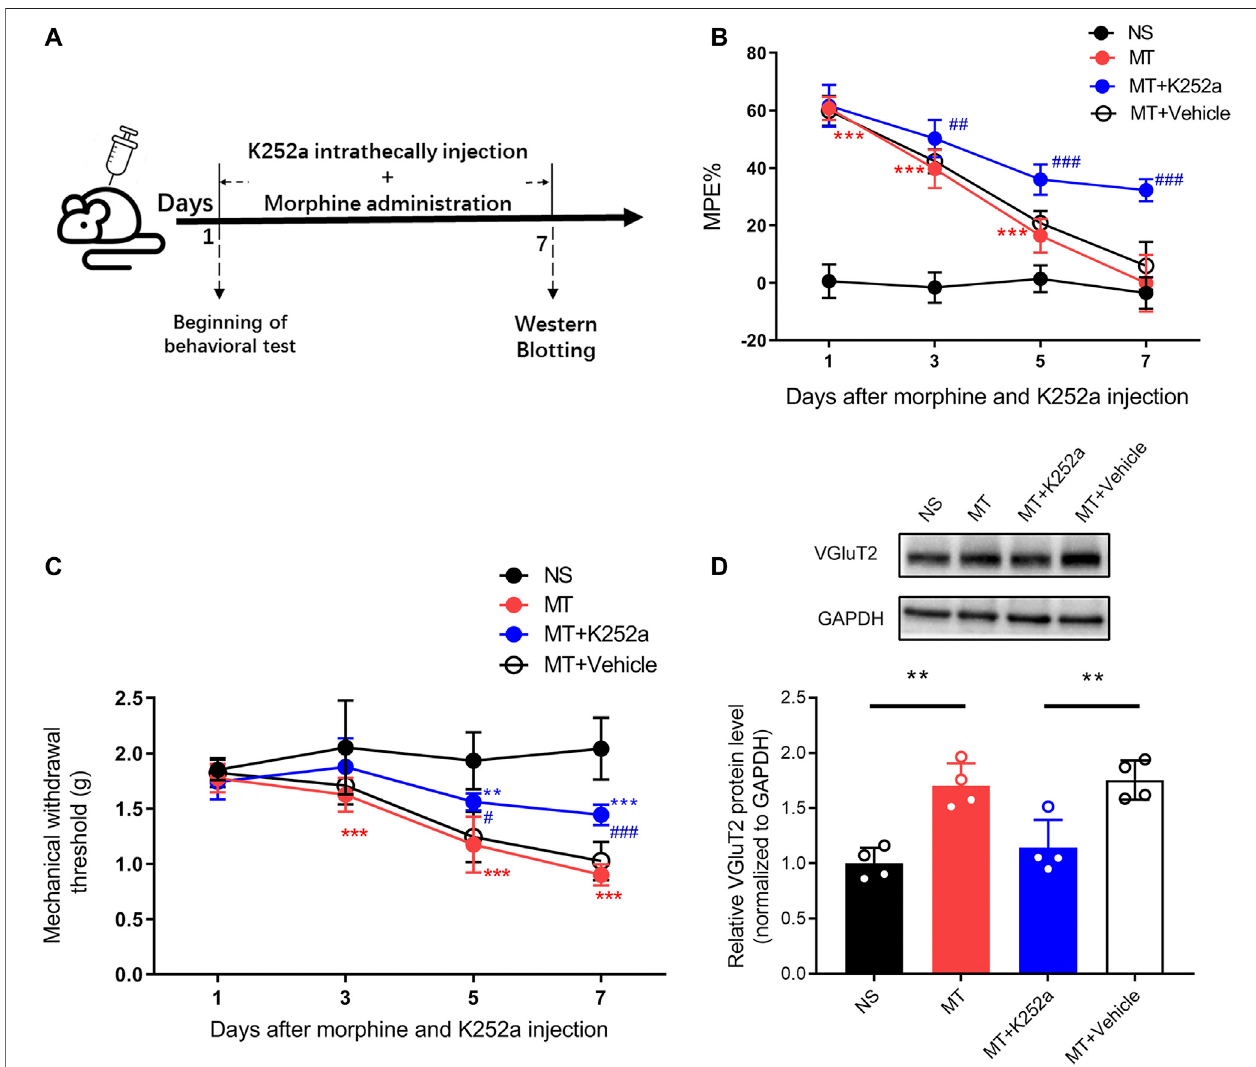
FIGURE 7 | Inhibition of the BDNF/TrkB pathway downregulates the expression of VGluT2 in the spinal cord (A) Schematic representation of the experimental procedure (B,C) Effect of K252a on morphine induced tolerance (B) and mechanical hyperalgesia (C) . n = 8, two-way ANOVA (B) F (3, 28) = 540.3, p < 0.0001 (C) F (3, 28) = 38.82, p < 0.0001 with Bonferroni correction. ** p < 0.01, *** p < 0.001, compared with NS, # p < 0.05, ## p < 0.01, ### p < 0.001, compared with MT + Vehicle. K252a (0.2 μ g/5 μ L) was injected intrathecally for seven consecutive days 30 min before each morphine injection (D) Western blotting test showing K252a decreases VGluT2 expression in mice spinal cord on day 7 after morphine injections. n = 4, one-way ANOVA, F (3, 12) = 15.14, p = 0.0002 with Bonferroni correction. ** p < 0.01.